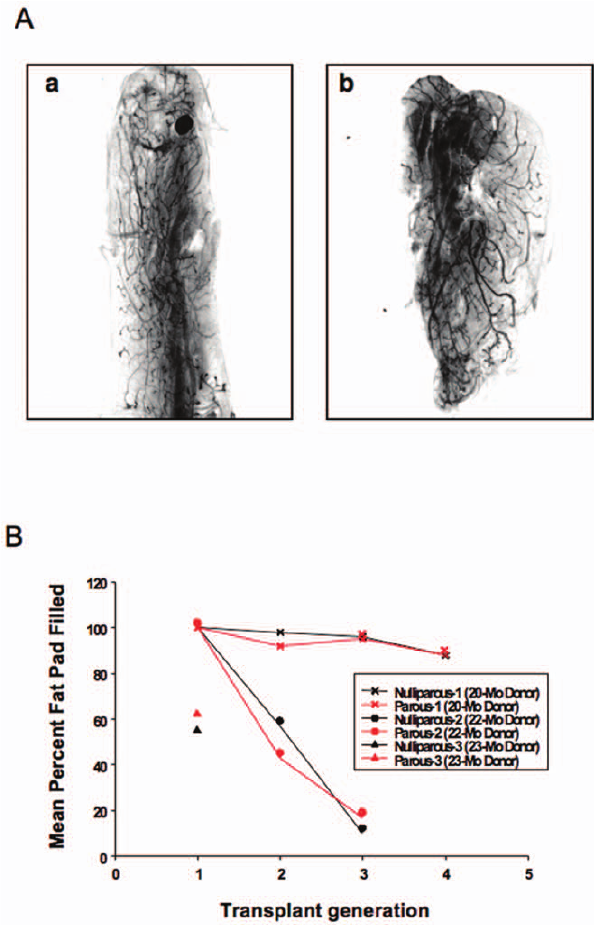
Figure 6. Transplantation results from implantation of mam- mary tissue fragments of, aged-nulliparous and aged-multip-